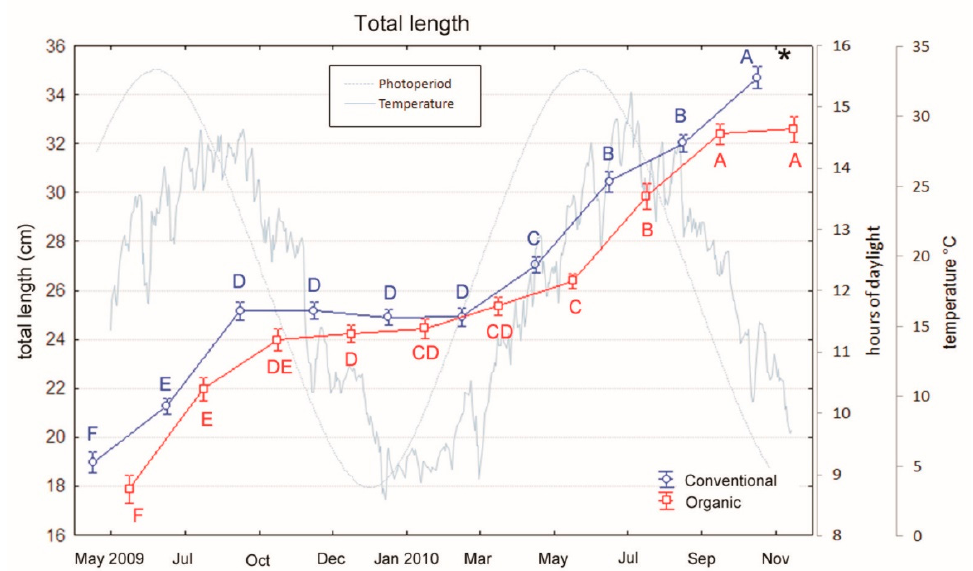
Figure 2. Variations in total length of sea bass over an 18-month period (mean ± SE) reared under conventional and organic aquaculture. Di ff erent letters indicate significant di ff erences in samplings within the same feeding system (organic or conventional; ( p < 0.05). Asterisk indicates significant di ff erences between feeding systems (organic vs. conventional) within the same sampling ( p < 0.05).